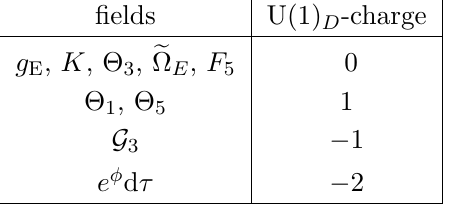
Table 1 . U(1) D charges of relevant